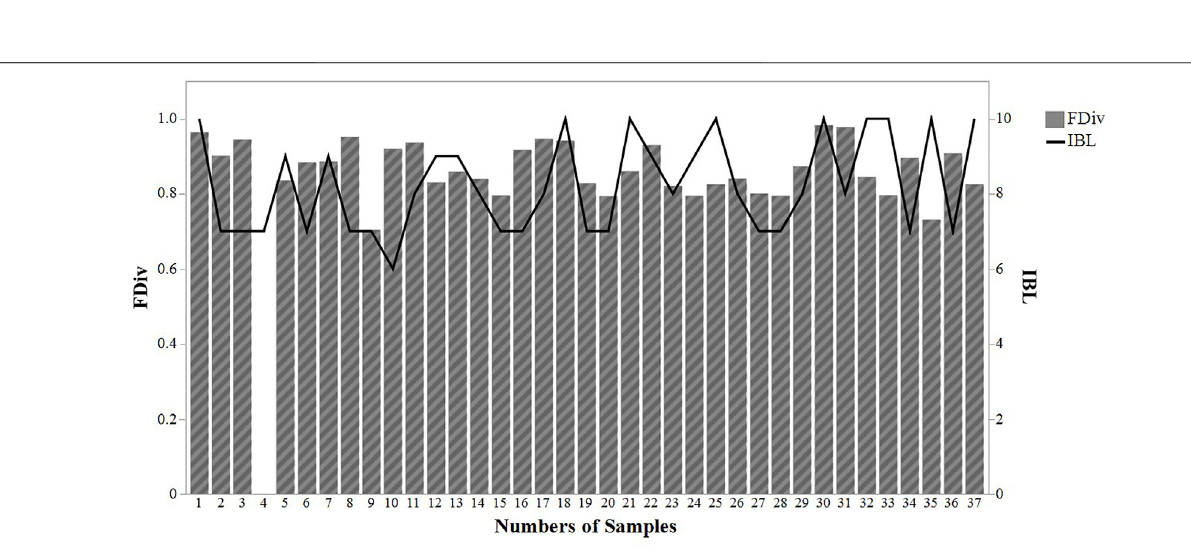
Frontiers in Environmental Science |